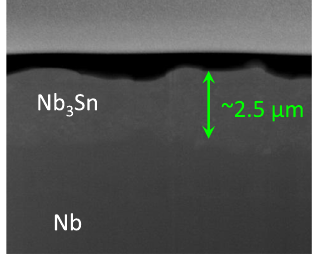
FIG. 5. Cross section near the surface of a witness sample.